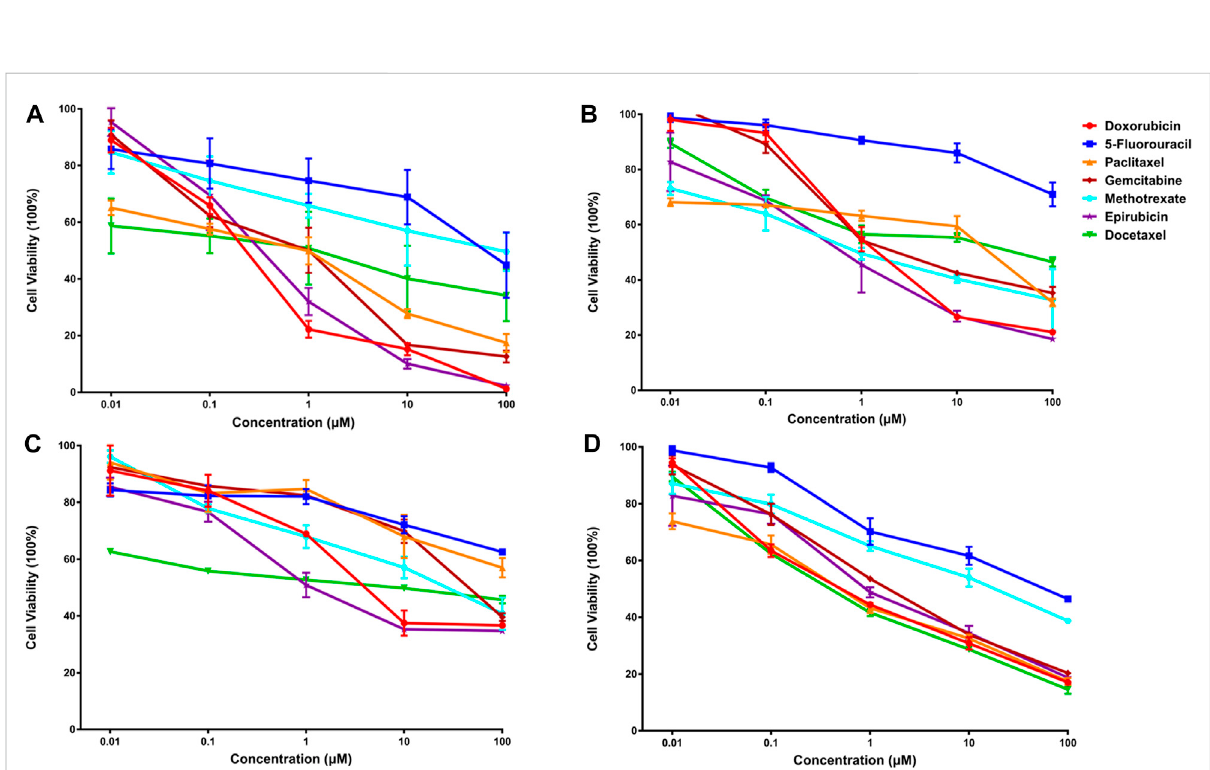
FIGURE 4 The anti-cancer effects of seven single drugs on four cancer cell lines (A) . The anti-cancer effects of seven single drugs on three breast cancer lines,includingluminalAsubtypeMCF-7 (A) ,basalsubtypeMDA-MB-468 (B) ,andclaudin-lowsubtypeMDA-MB-231 (C) .Also,theanti-tumorability of seven individual drugs were examined on a lung cancer cell A549 (D)